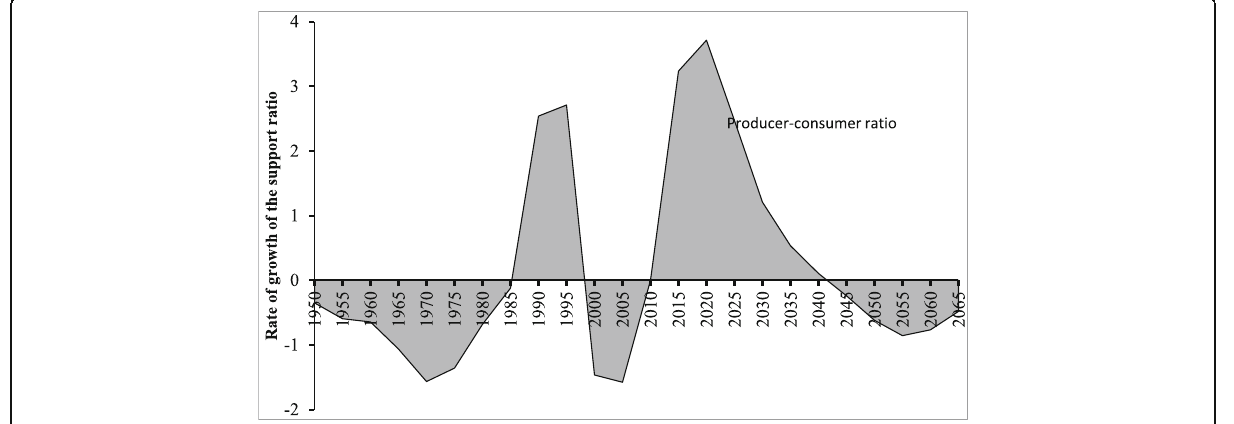
Fig. 8 Estimated period of demographic dividend in Oman. Source: UN population estimates and projection